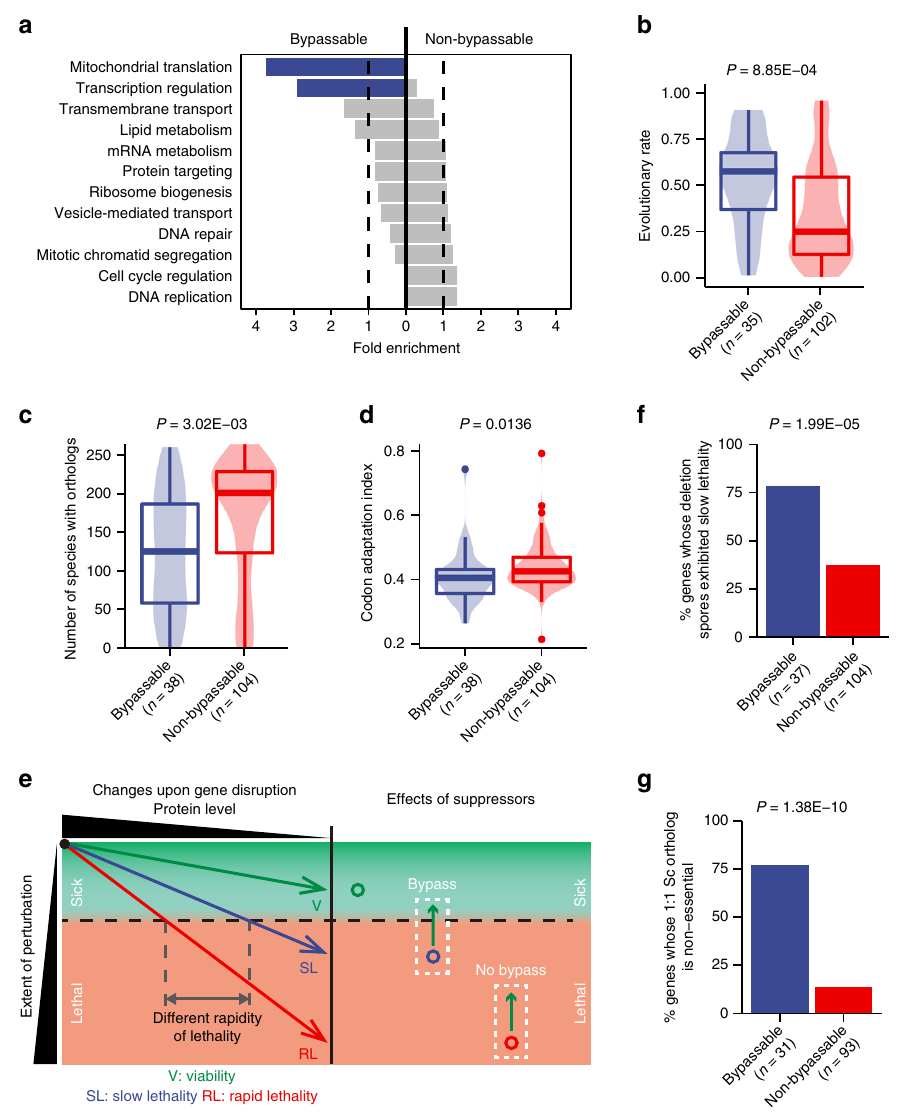
Fig. 3 Essentiality bypass preferentially occurs to essential genes with lower importance and essential genes exhibiting differential essentiality between species. a Two GO slim terms were signi fi cantly enriched among bypassable essential genes (Fisher ’ s exact tests, P = 6.35E-05 and 0.00146, respectively, for the two terms at the top). b – d Evolutionary rate ( b ), the number of species harboring orthologs ( c ), and codon adaptation index ( d ) exhibit correlations with bypassability (Mann – Whitney – Wilcoxon tests). e A model explaining the relationships between gene importance, rapidity of lethality upon gene disruption, and bypassability. Arrowed lines in the left panel show the perturbation becoming more severe as the protein product of the disrupted gene is being depleted. For a non-essential gene (green), the perturbation extent never reaches the lethal threshold (the dashed horizontal line). For essential genes, the threshold is crossed later for a less important gene whose loss results in a weaker perturbation (blue) than for a more important gene whose loss results in a more severe perturbation (red). The former is more likely to be bypassable by ectopic suppressors than the latter (right panel). f , g Percentages of genes exhibiting slow spore lethality ( f ) and percentages of genes whose one-to-one S. cerevisiae ortholog is non-essential ( g ) (Fisher ’ s exact tests). Boxplots show median (centerline), interquartile range (box), and most extreme data points no further than 1.5-fold interquartile range from either end of the box